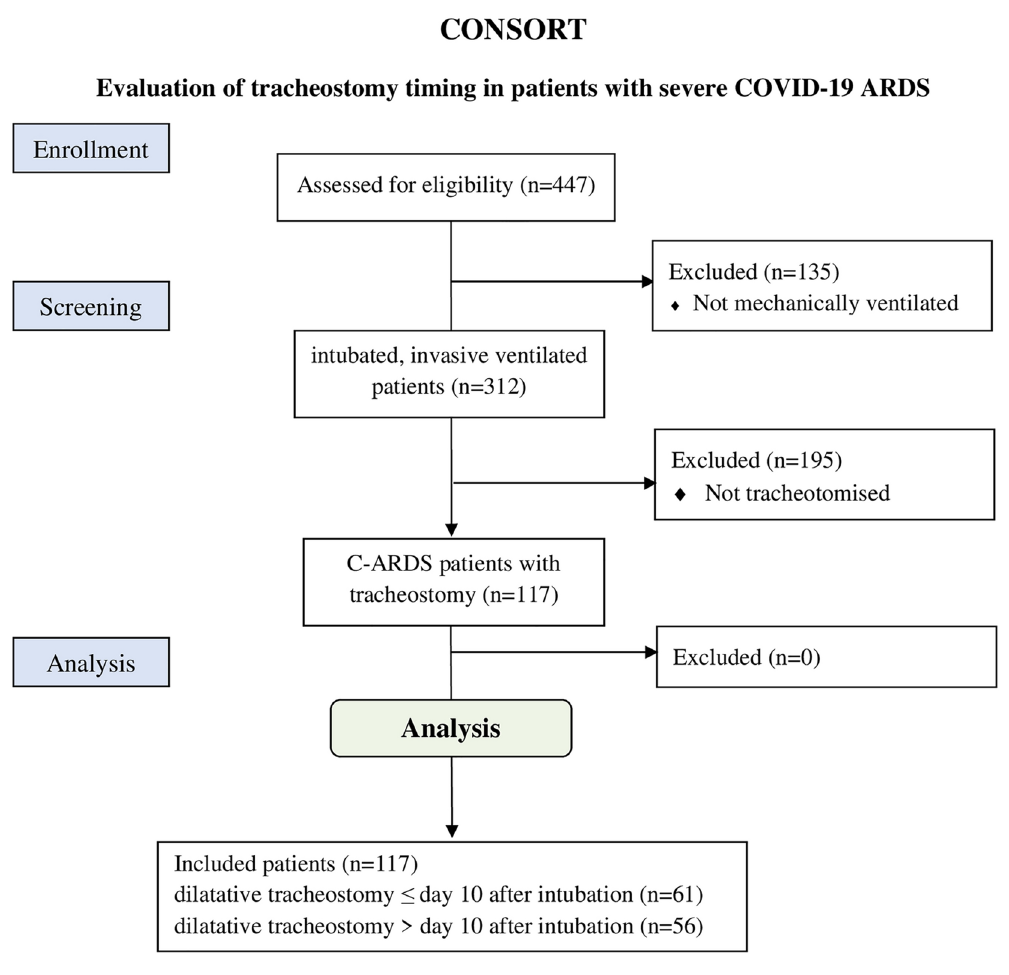
Figure 1. Consolidated Standards of Reporting Trials (CONSORT) diagram of patients included into the study. Diagram of the inclusion process, as well as the reasons for